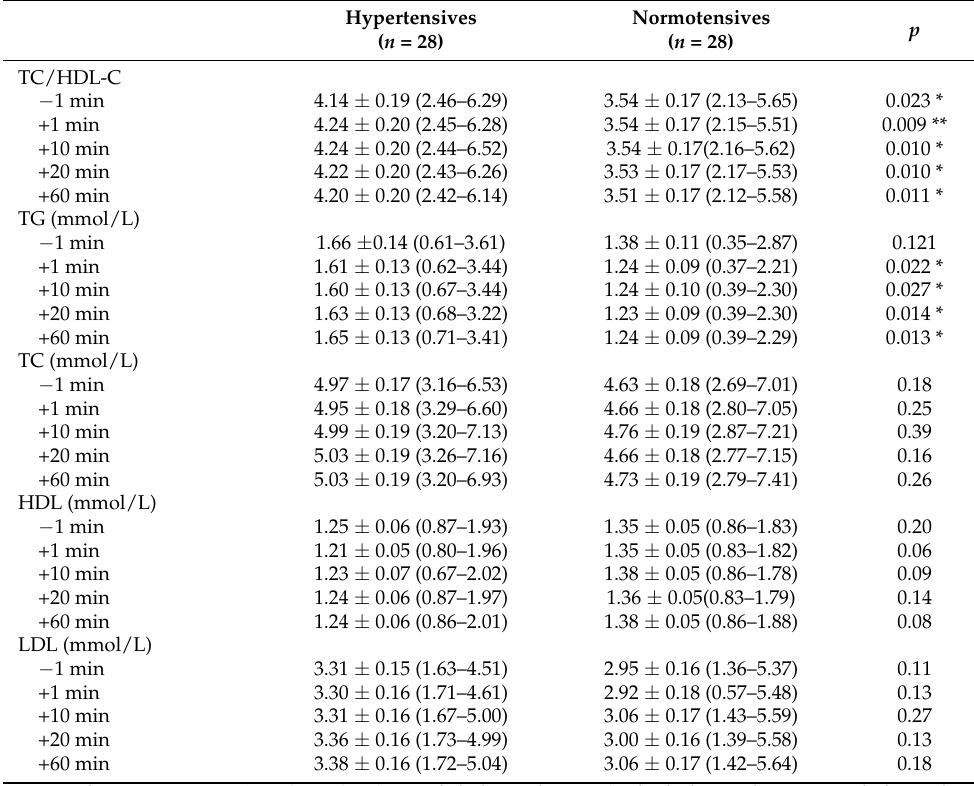
Table A2. Blood lipid reactivity in hypertensive and normotensive